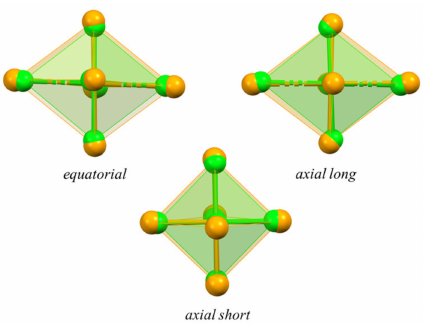
Figure 3. Projections of CuX 6 octahedra in aacn 2 CuCl 4 (green) and aacn 2 CuBr 4 (orange) on equa- torial plane and two perpendicular axial planes. Cu-Br bonds are usually significantly longer than appropriate Cu-Cl bonds in these